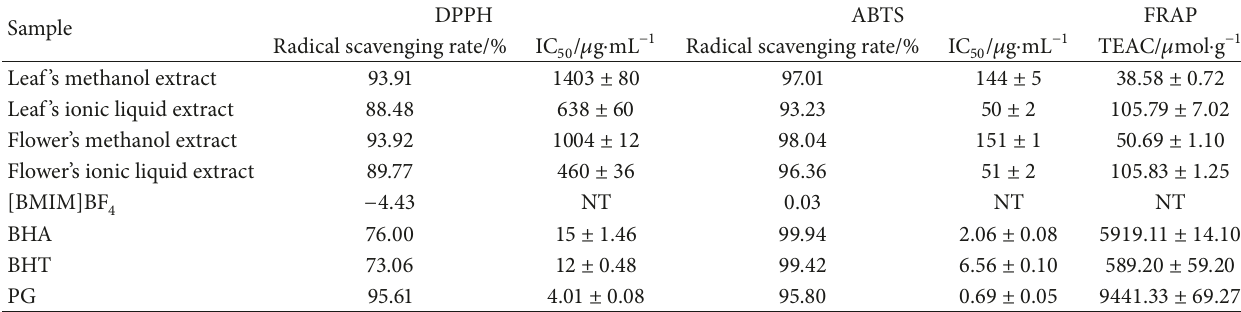
Table 3: Antioxidant activity of the different extracts of L. clethroides